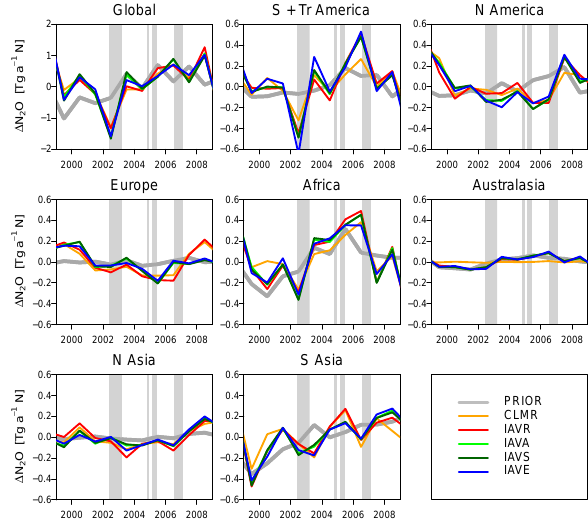
Fig. 7. Global and land regions annual flux anomalies (units of Tga − 1 N). The grey-shaded areas indicate El Niño events (MEI ≥ 0.6).